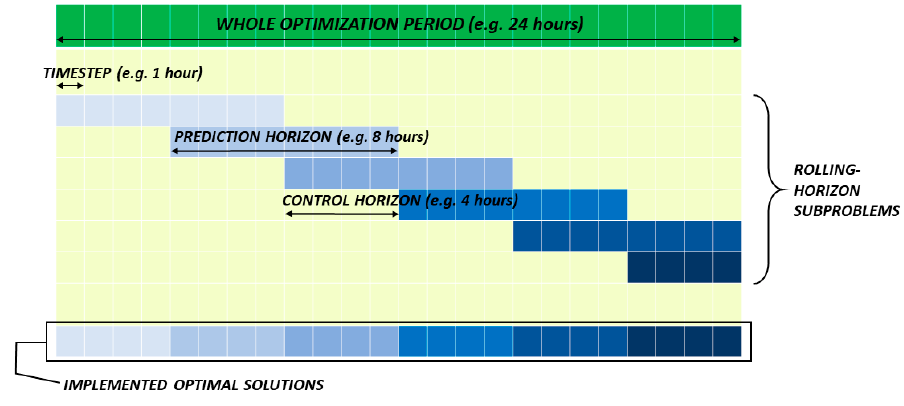
Figure 3. Rolling-horizon approach.